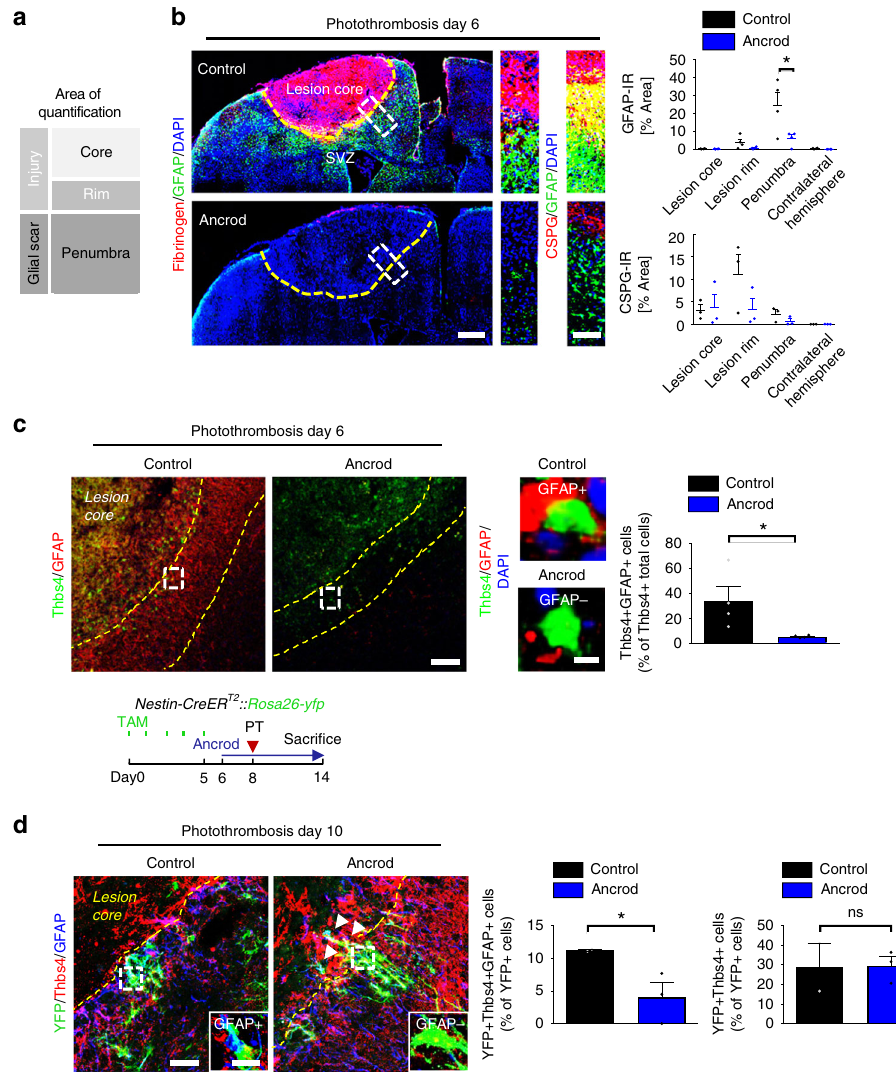
Fig. 5 Fibrinogen-induced SVZ astrocytes add to cortical scar. a Representation of the different lesion regions quanti fi ed by immunoreactivity. b Fibrinogen deposition (red) and GFAP + astrocytes in the brain of fi brinogen-depleted mice (Ancrod) compared to controls (NaCl) at 6 days after PT (left). Yellow dotted line delineates the lesion area. The white boxes indicate the enlargement of the lesion region quanti fi ed for GFAP (right, top) and CSPGs (right, bottom) immunoreactivities. Quanti fi cations of GFAP and CSPG immunoreactivities in the different lesion regions ( n = 4 mice, mean ± s.e.m, one-way ANOVA and Bonferroni ’ s multiple comparisons test, * P < 0.05). c Immunolabeling for Thbs4 (green) and GFAP (red) in the lesion area of ancrod and control mice at 6 days after PT. Yellow dotted lines delineate the penumbra. The white boxes indicate the enlargement of a Thbs4 + GFAP + cell (top, right) in controls and Thbs4 + GFAP- cell in ancrod mice (right, bottom). Quanti fi cation of Thbs4 + GFAP + astrocytes in the penumbra of ancrod and control mice ( n = 4 mice, mean ± s.e.m, unpaired Student ’ s t -test, * P < 0,05). d Experimetal setup for ancrod-administered Nestin-CreER T2 ::Rosa26-yfp mice. TAM: tamoxifen (top). YFP (green), Thbs4 (red) and GFAP (blue) immunostainings in the lesion area of ancrod and control mice at 10 days after PT. Yellow dotted lines delineate the lesion area. The white boxes indicate the enlargement of an YFP + Thbs4 + GFAP + cell in control and YFP + Thbs4 + GFAP- cell in ancrod mice. Quanti fi cations of YFP + Thbs4 + GFAP + astrocytes (left) and YFP + Thbs4 + cells (right) in the penumbra of ancrod and control mice ( n = 2 control mice, n = 3 ancrod mice, unpaired, one-tailed Student ’ s t -test, * P < 0,05, ns, not signi fi cant). SVZ subventricular zone. factor fi brinogen drives the differentiation of NSPCs into astro- type I receptor, thereby promoting Thbs4 + NSPC differentiation cytes via a BMP signaling-dependent mechanism. In the unin- into potentially neuroprotective astrocytes (Fig. 6). Thus, local fi brinogen deposition might exert a critical role in regulating the jured CNS, SVZ-derived adult NSPCs migrate along the rostral migratory stream to the olfactory bulbs to differentiate into fate of different stem cell types with neurogenic potential at sites interneurons. Our results suggest the following working model in CNS disease: (i) cortical brain injury increases SVZ vasculature permeability and allows fi brinogen deposition in the micro- environment of SVZ stem cells (Fig. 6). (ii) fi brinogen activates BMP type I receptor signaling in NSPCs through its α C domain. (iii) fi brinogen induces Smad1 phosphorylation and increases the expression of the transcriptional regulator Id3 through the BMP NATURE COMMUNICATIONS| (2020) 11:630